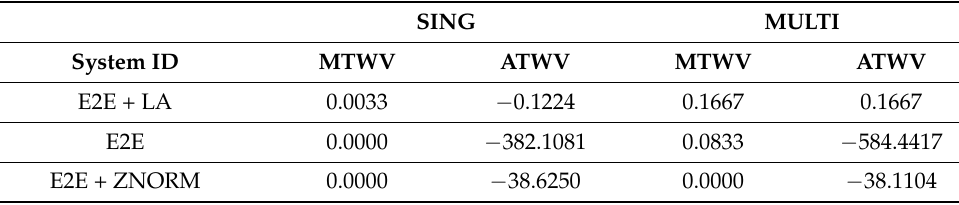
Table 29. System results of the QbE STD task for MAVIR test data for single-word (SING) and multi-word (MULTI)